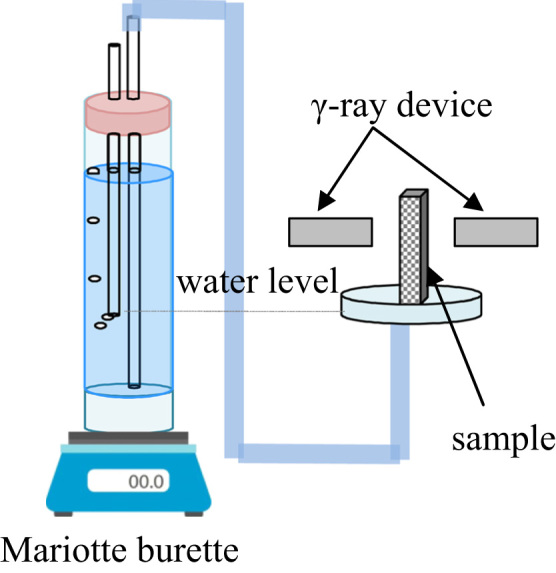
Experimental set up.